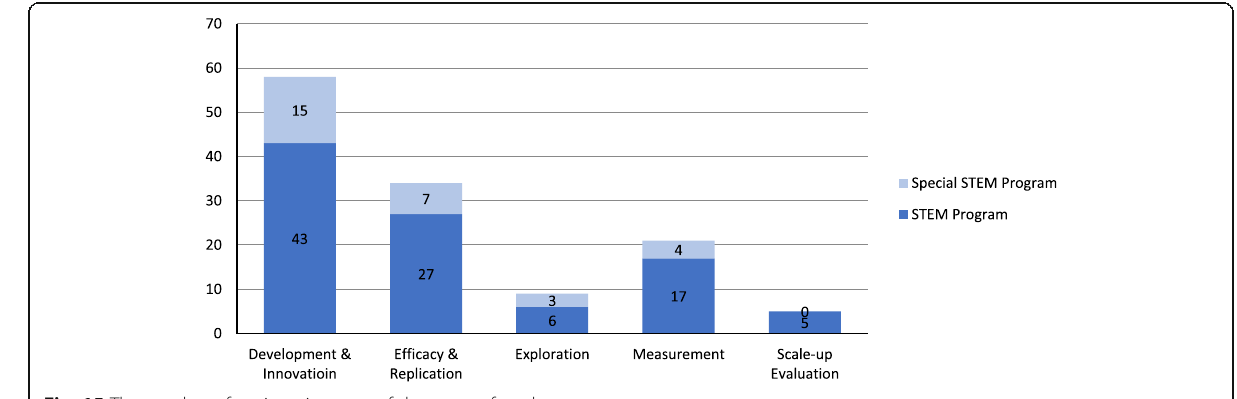
Fig. 15 The number of projects in terms of the types of